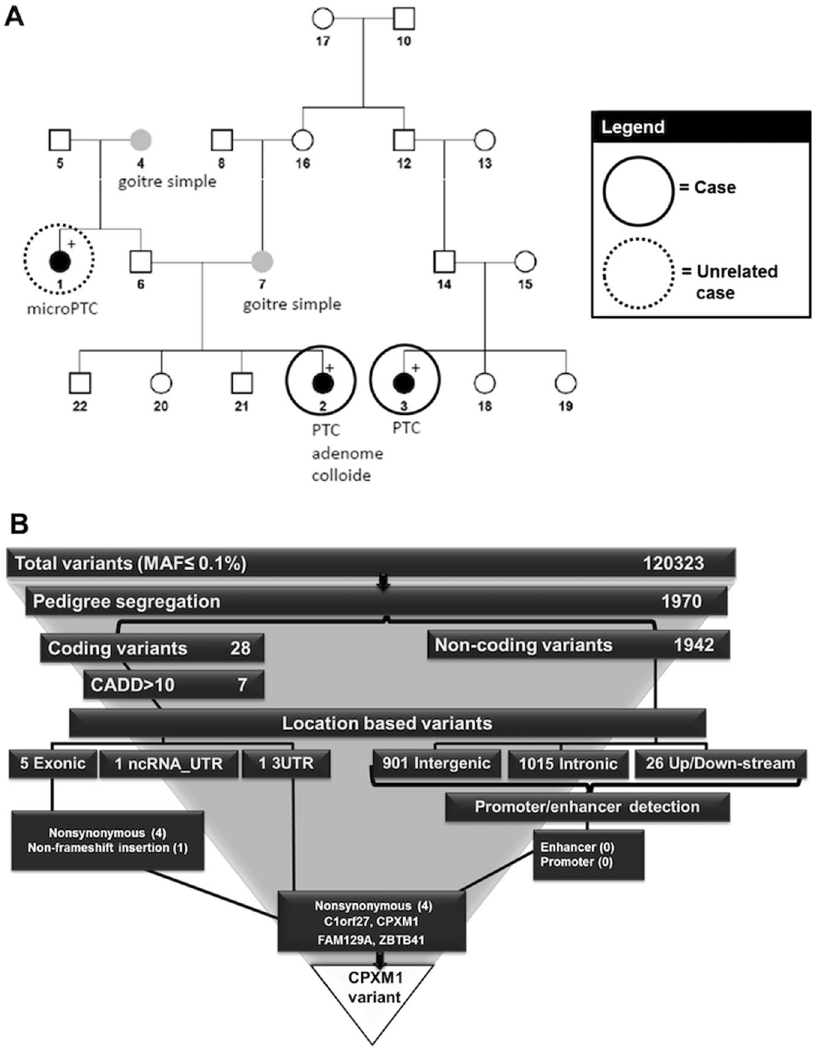
Figure 3. Summary of the papillary thyroid cancer (PTC) family and variant ranking within this family. ( A ) Pedigree of the PTC family. ( B ) Variant ranking for the PTC family and selection of CPXM1 variant as the top deleterious